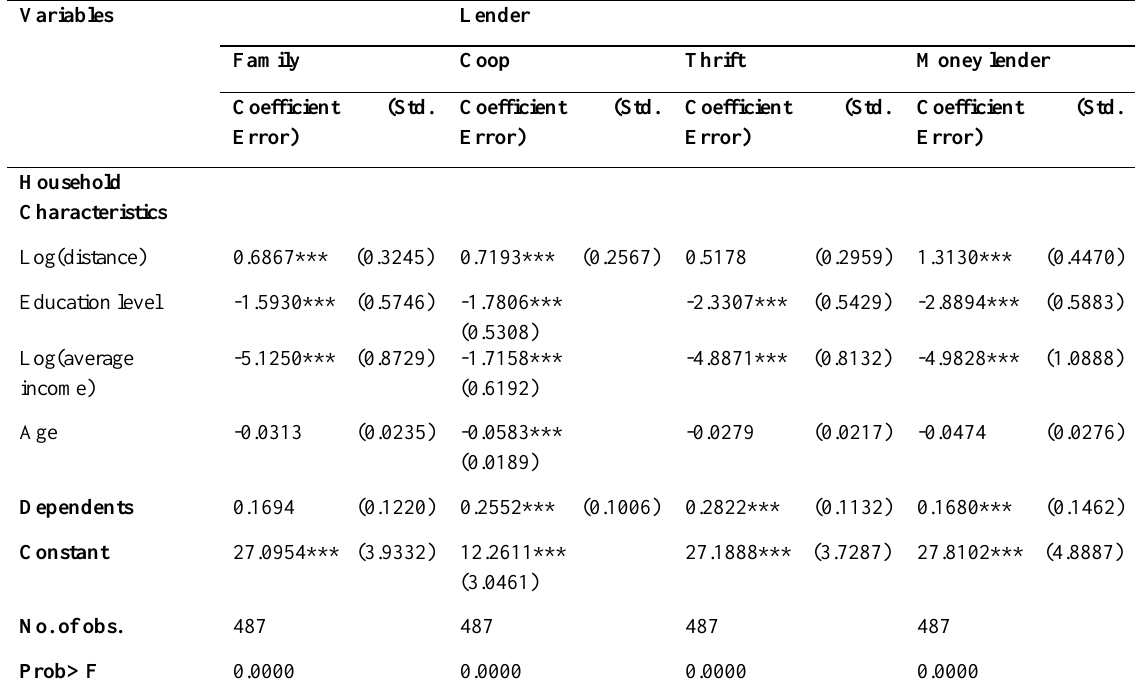
Table 5 : Determinant of the choice of a credit